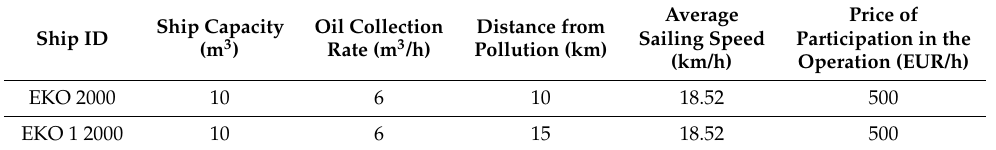
Table 16. Example 3—input